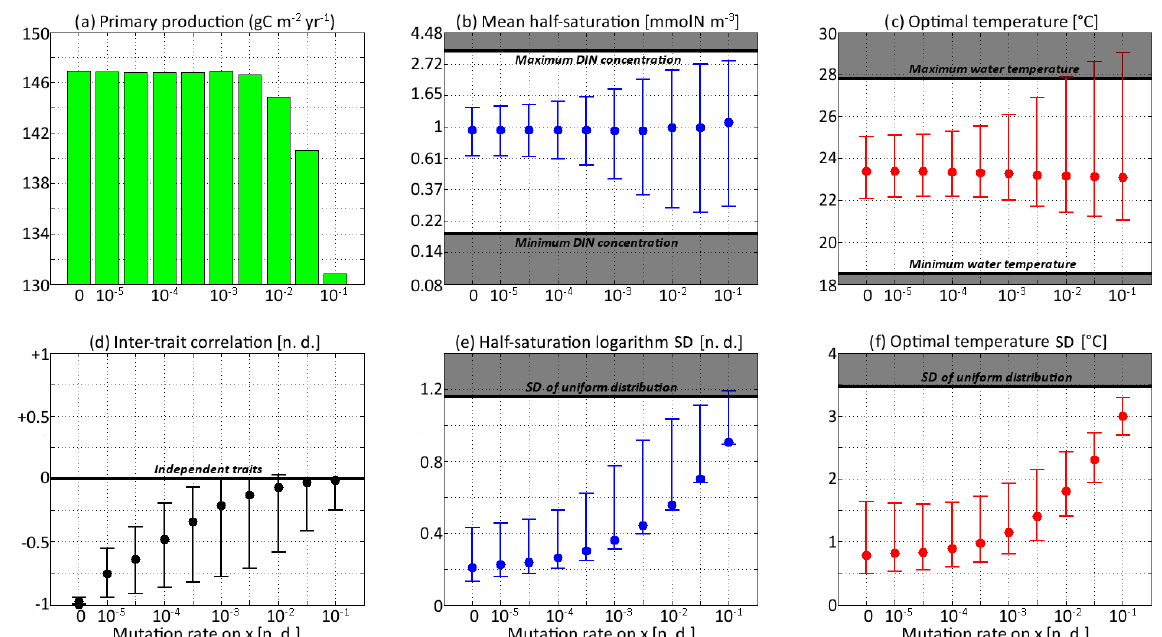
ν y is kept constant and equal to 10 ◦ C 2 . ν x